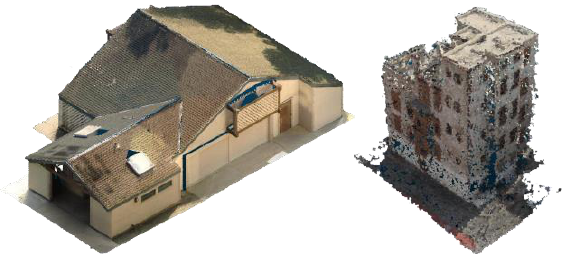
Figure 2. Point clouds from PolyFit sample data – Detached house on the left, tall building on the right.